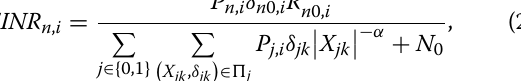
can access the frequency spectrum of PUs. The SUs are under power control because the communication of the PUs cannot be seriously interfered. On each band, the frequency spectrum of the primary network is divided into several frequency-flat sub-channels by utilizing an orthogonal frequency-division multiplexing